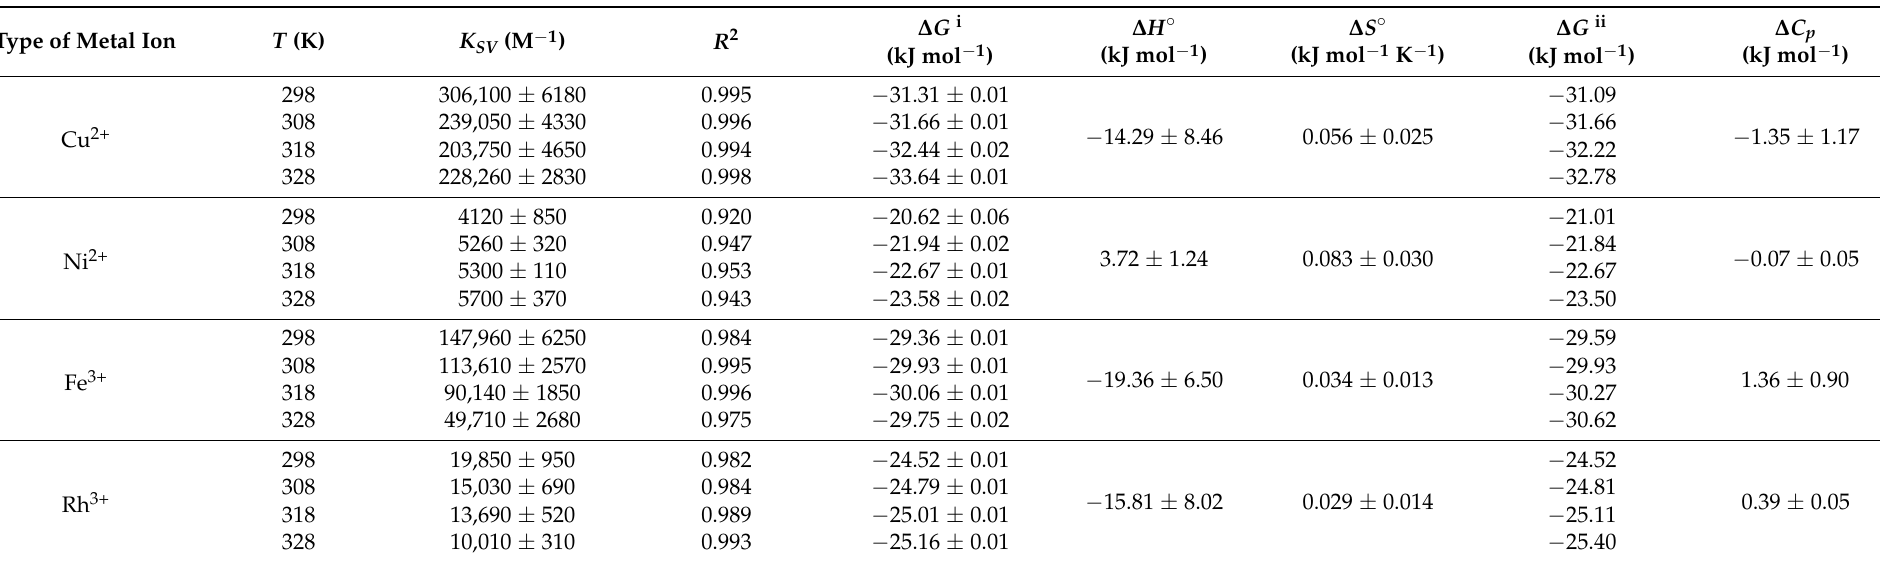
Table 2. Fitted Stern-Volmer constant ( K SV ) of the interaction between Tyr-AgNCs and Cu 2+ , Ni 2+ , Fe 3+ and Rh 3+ ions with the correlation coefficients ( R 2 ), the calculated ∆ G values calculated by Equations (3) and (5), the standard enthalpy ( ∆ H ◦ ) and standard entropy ( ∆ S ◦ ) changes by the nonlinear Van’t Hoff regression at four different temperatures ( T